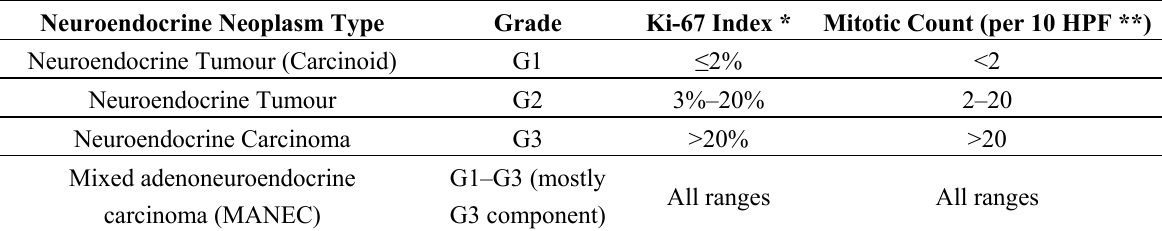
Table 1. World Health Organization (WHO) 2010